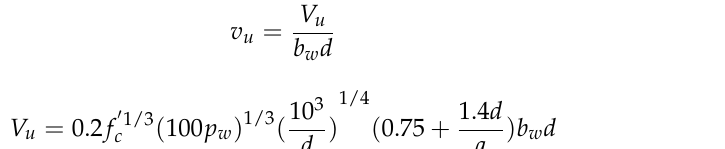
Figure 20. Shear strength of the RC beams and material properties of the concrete.